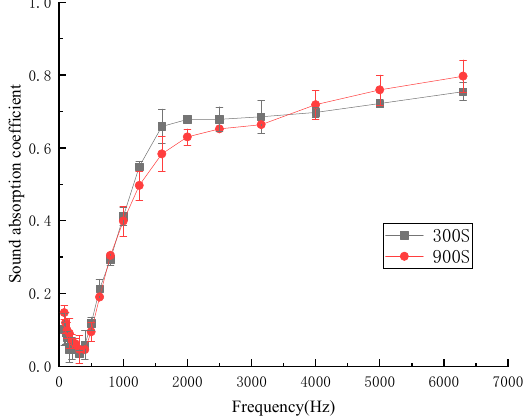
Figure 4. Sound-absorption coefficient at different hot pressing times.